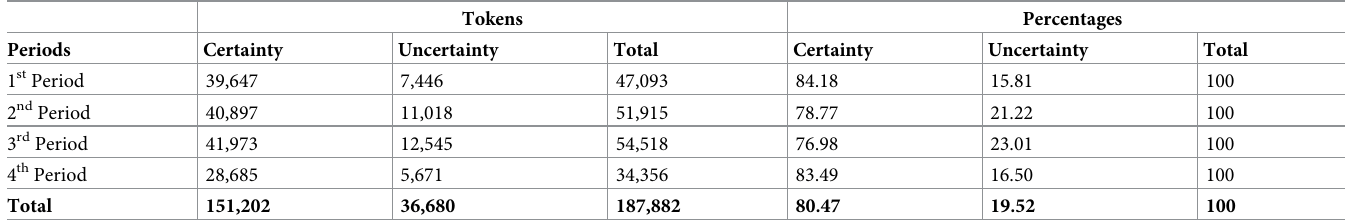
Table 3. Certainty and uncertainty tokens and percentages for each